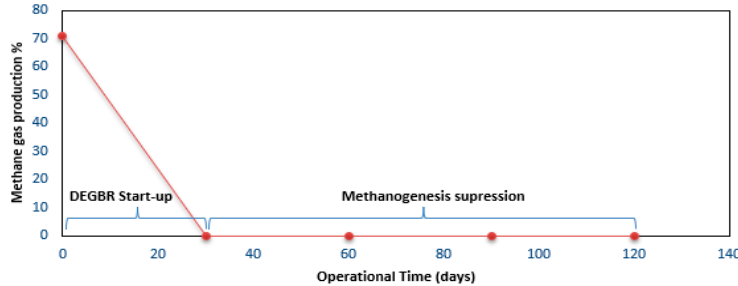
Figure 16. Biogas production during the operation of the DEGBR.